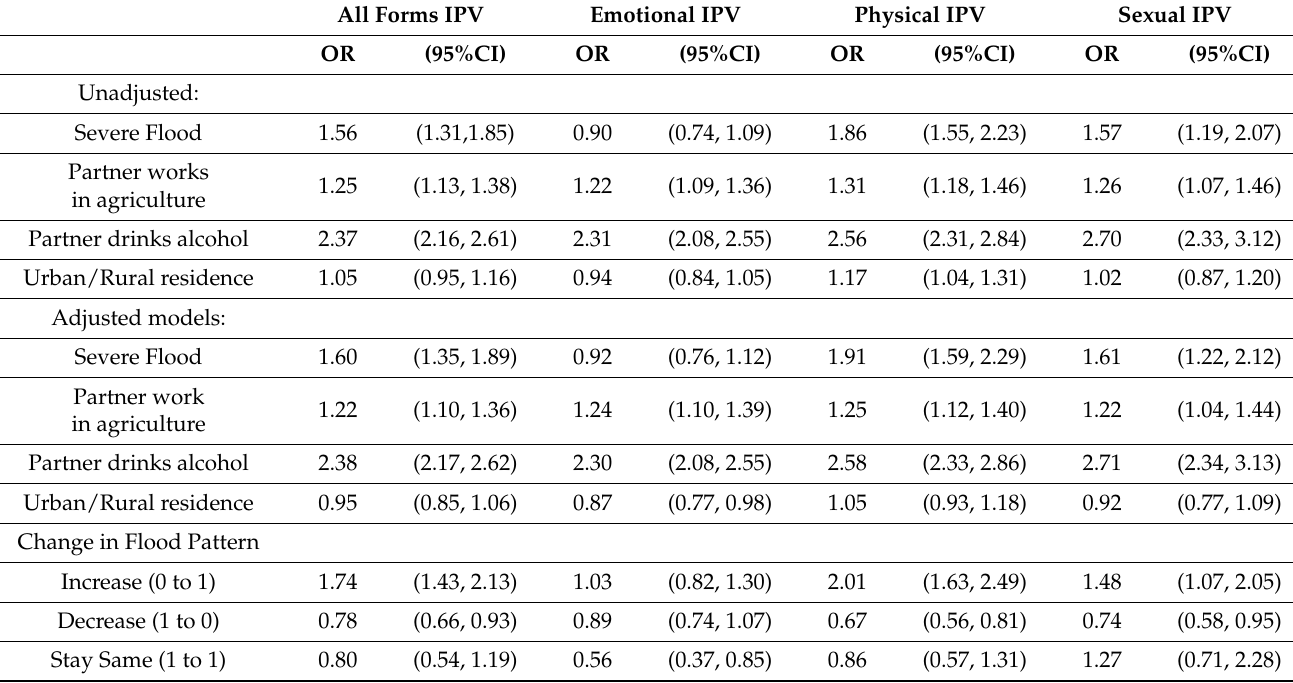
Table 2. Odds of Having Experienced Intimate Partner Violence by Severe Flood Events N = 9415 for 47 County Data. All Forms IPV Emotional IPV Physical IPV Sexual IPV